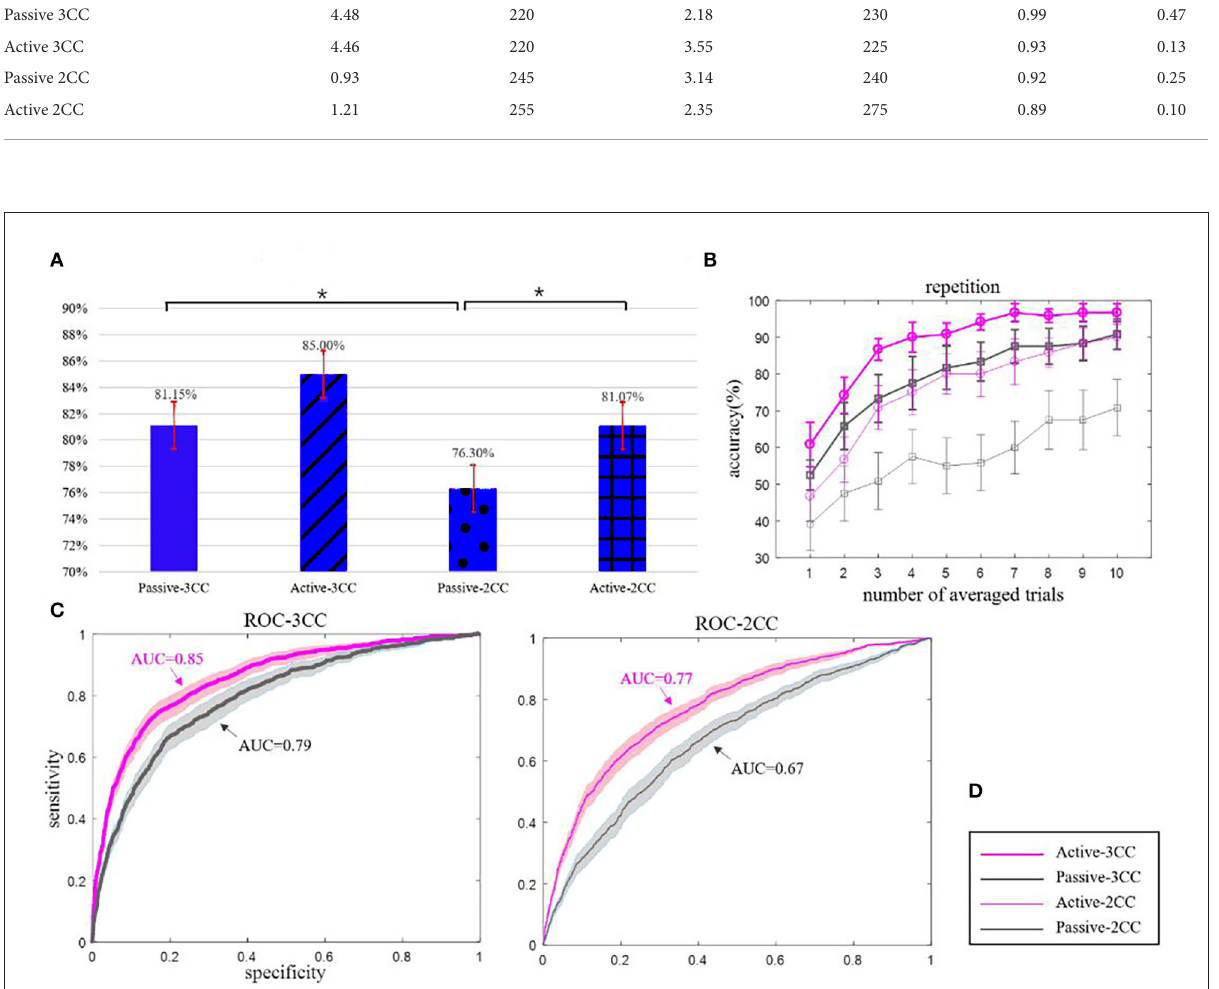
there is no significant difference in accuracy rate between active and passive in the case of 3CC non-target ( p difference in the case of 2CC non-target is very significant ( p